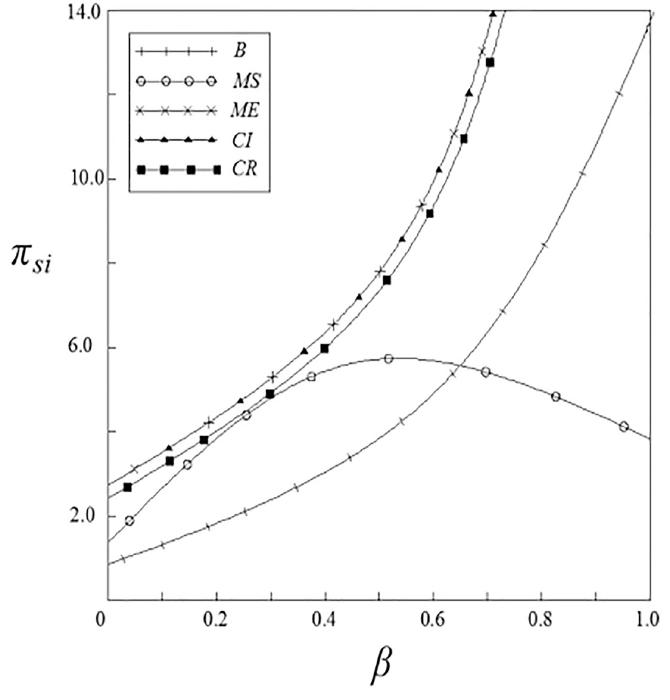
Fig 12. The relationship between π si and β .